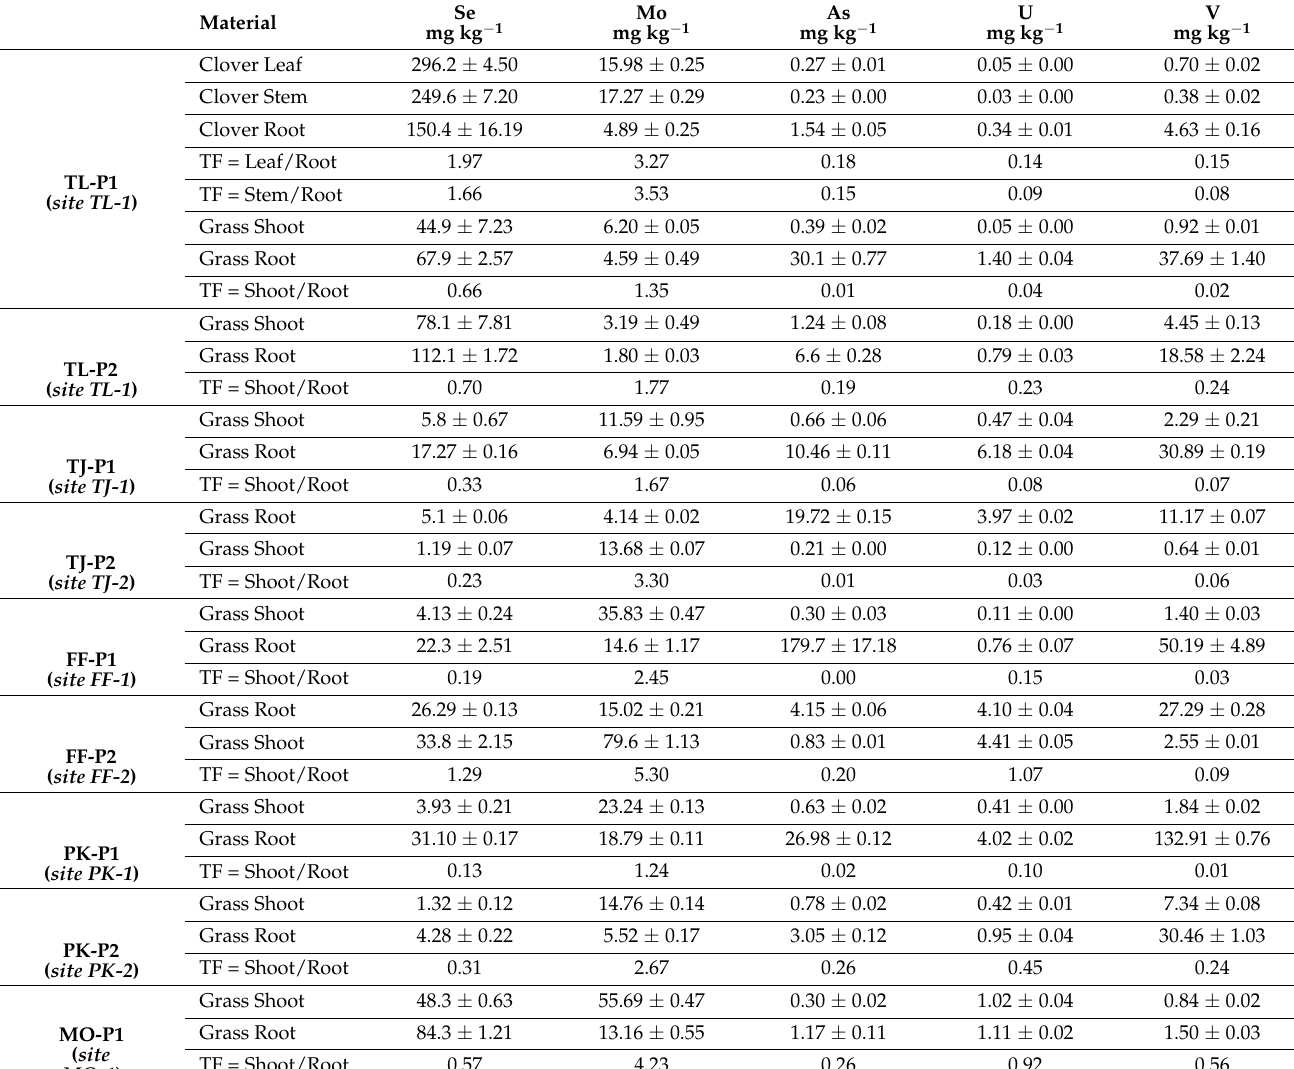
Table 3. The concentration of Se, Mo, As, U and V in selenium ‘non-accumulator’ clover and grass from pasture in West Limerick. TF = the translocation factor, a value >1 indicates the plant can translocate the element effectively from the root to shoots, stem and leaves. Analysis by ICP-MS, all experiments performed in triplicate ± the standard error. Nearest soil sample sites are in